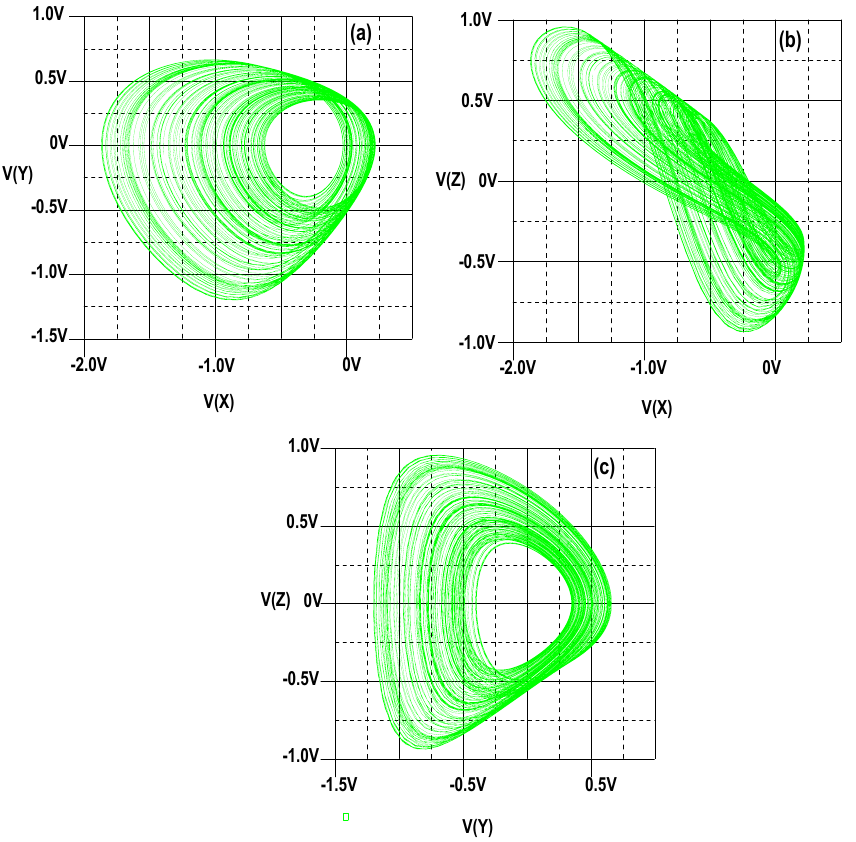
Figure 11. Hidden chaotic attractor of system (29): ( a ) X-Y projection of the attractor, ( b ) X-Z projection of the attractor, and ( c ) Y-Z